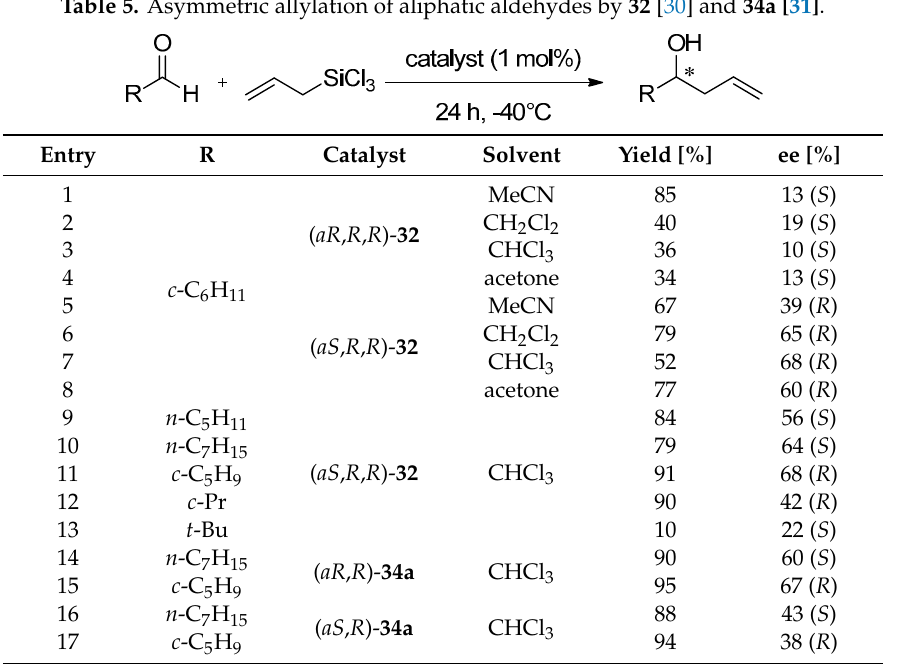
Table 5. Asymmetric allylation of aliphatic aldehydes by 32 [30] and 34a [31] .